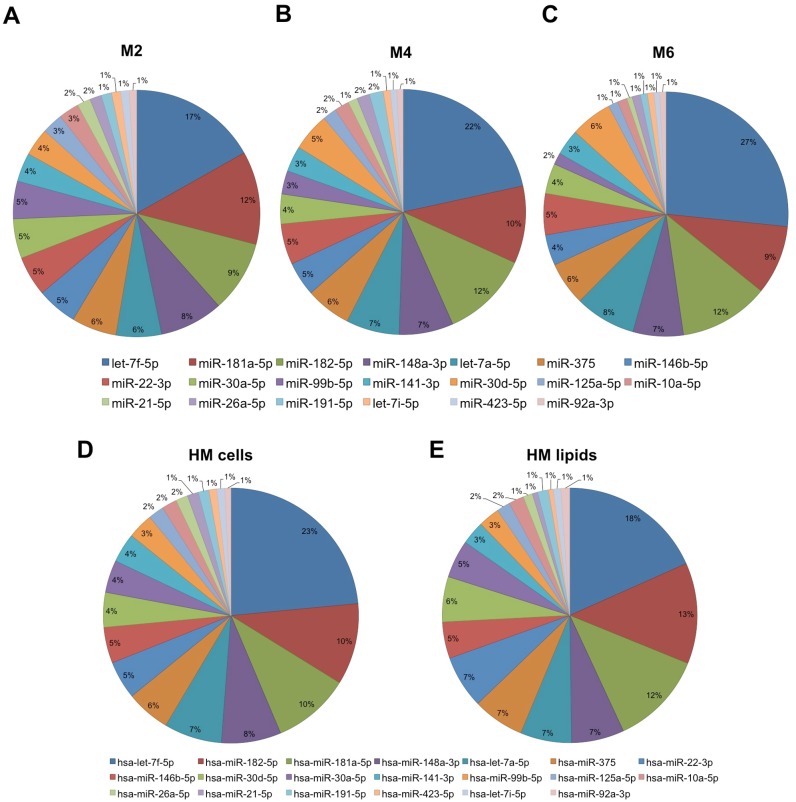
Distribution percentage of the top 20 most highly expressed known miRNA species in each stage of lactation examined (months 2, 4 and 6; n = 10 in each month) (A-C), and in HM cells (n = 30) (D) and lipids (E) (n = 15).The top 20 most highly expressed known miRNAs contributed 88.8±1.4% of all identified known miRNAs.